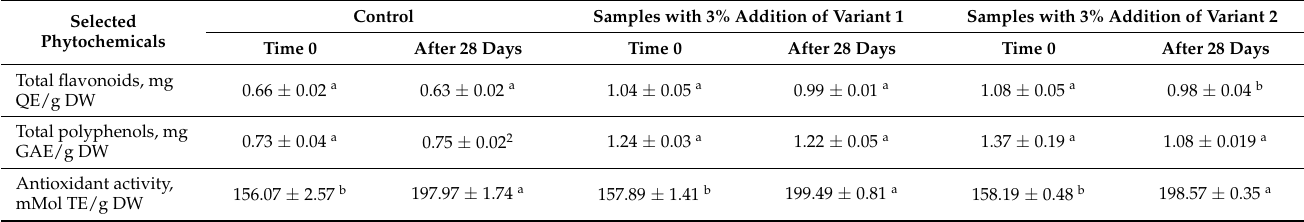
Table 2. Phytochemical profile of added-value nachos and stability during 28 days of storage. Control Samples with 3% Addition of Variant 1 Samples with 3% Addition of Variant Selected Phytochemicals